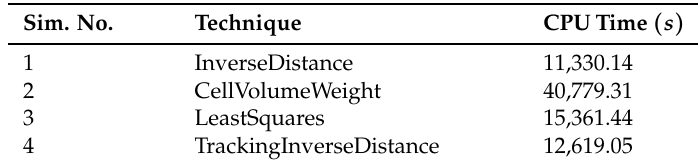
Table 3. CPU time requirement for different interpolation schemes employed for 2D stationary panel at α = 30